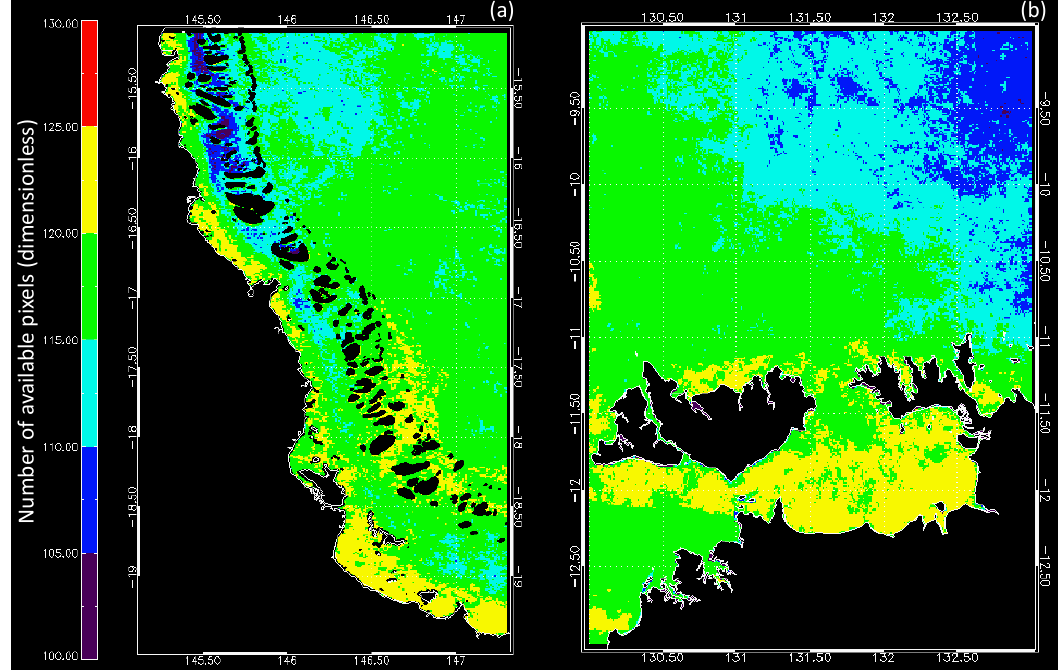
Figure 3. Satellite data observations for ( a ) the Great Barrier Reef Wet tropics (GBRW) and ( b ) the Van Diemen Gulf (VDG) over the MERIS mission (April 2002–April 2012). The number of available pixels was computed from monthly composites (N = 133).